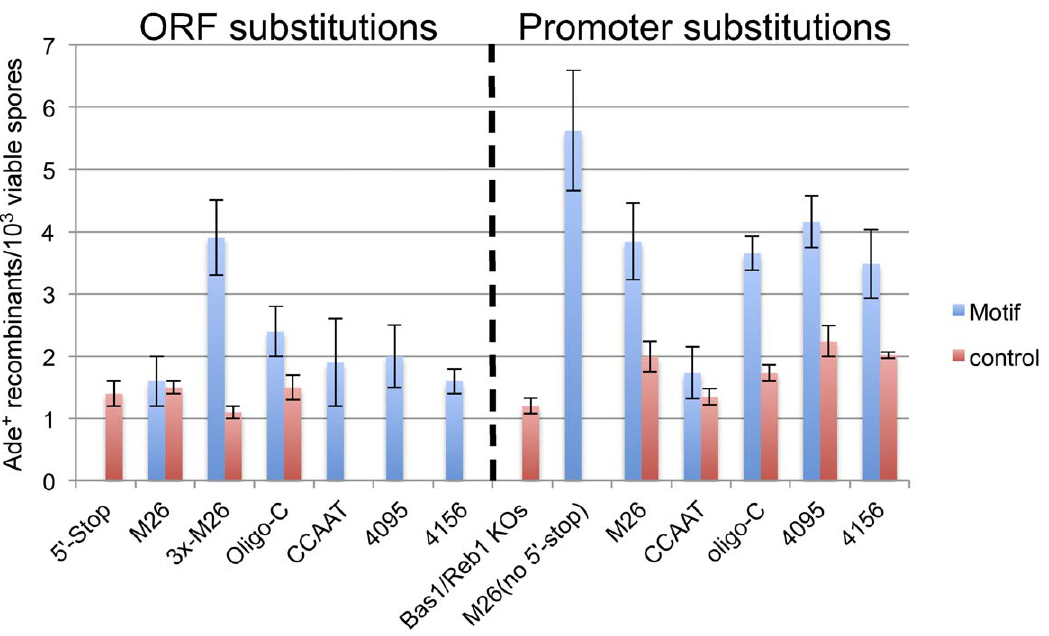
Figure 2. Most S.pombe hotspot motifs are active in the ADE2 gene of S.cerevisiae. Each of the indicated motifs was tested in the ADE2 coding sequence (ORF substitutions; left), or promoter (promoter substitutions; right). Bars indicate the mean frequency of Ade + recombinants from at least three crosses of the indicated motif (blue) and its corresponding control (red) when crossed with Wsc72 ( ade2-1003 ) . Error bars indicate one standard deviation. Strains crossed to Wsc72 are from left to right: Wsc66 (5 9 -Stop; ade2-1007 ), Wsc64 and 169 ( M26 and control; ade2-1006 and - 1050 ), Wsc70 and 120 (3x- M26 and control; ade2-1008 and -1030 ), Wsc94 and 136 ( Oligo-C and control; ade2-1015 and -1036 ), Wsc92 ( CCAAT ; ade2- 1014 ), Wsc97 ( 4095; ade2-1016 ), Wsc103 ( 4156; ade2-1017 ), Wsc168 (Bas1/Reb1 KOs; ade2-1049 ), Wsc110 ( M26 no 5 9 -stop; ade2-1021 ), Wsc115 and 116 ( M26 and control; ade2-1025 and -1026 ), Wsc118 and 167 ( CCAAT and control; ade2-1028 and -1048 ), Wsc125 and 135 ( Oligo-C and control; ade2-1032 and -1035 ), Wsc121 and 156 ( 4095 and control; ade2-1031 and ade2-1038 ), Wsc117 and 134 ( 4156 and control; ade2-1027 and -1034 ).